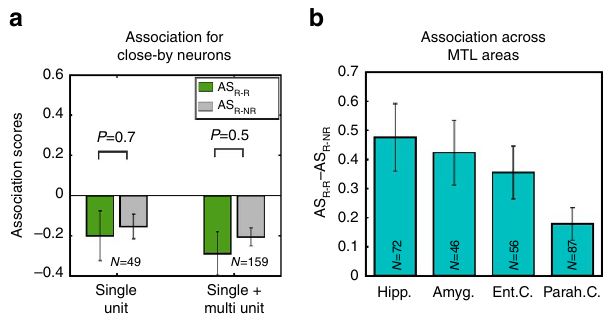
Figure 4 | Topographic analysis. ( a ) Mean association scores AS R-R (green) and AS R-NR (grey) between pictures eliciting responses in nearby neurons, which were recorded from the same electrode and separated after spike sorting. In this case N indicates the number of electrodes with at least two responsive units separated after spike sorting. ( b ) Mean association score for the pairs of images eliciting responses for the different MTL areas. rank test; for sample sizes see Supplementary Table 2). The difference